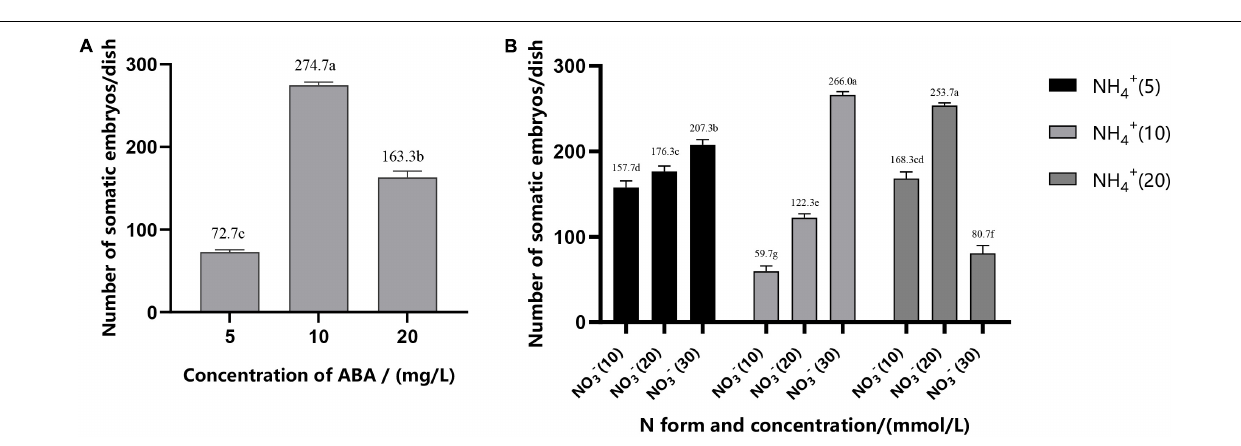
FIGURE 5 | Effect of ABA concentration (A) , N form, and concentration (B) on the synchronization of mature cotyledonary embryos in Pinus elliottii × Pinus caribaea . The different lowercase letters indicate significant differences ( P < 0.01) between treatments based on Duncan’s test. Data represent the mean ± SD of three